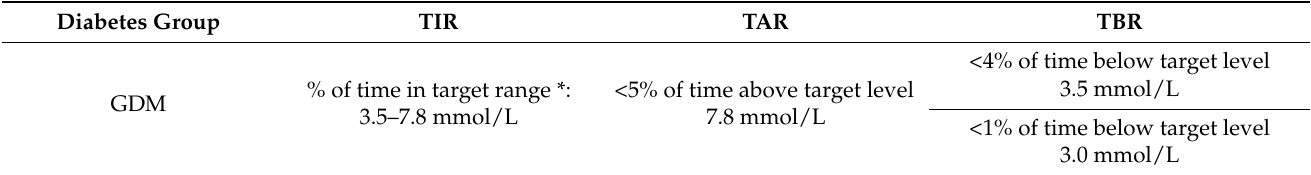
Table 1. CGM-based TIR targets for